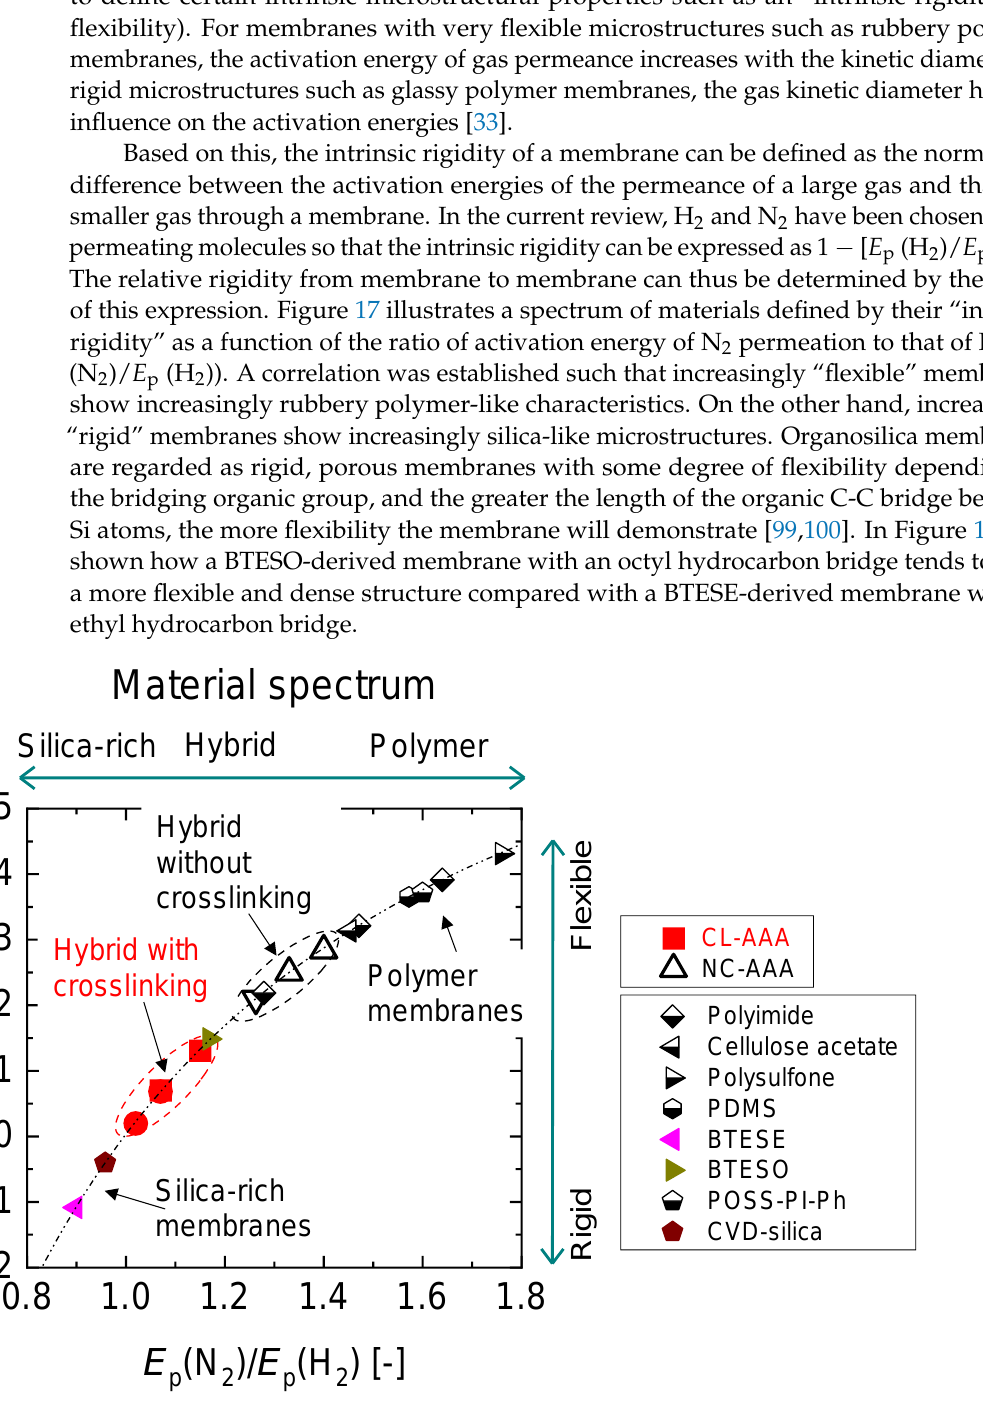
Figure 17. The correlation between “intrinsic rigidity” of 1 − [ E p (H 2 )/ E p (N 2 )] and material class calculated based on E p (N 2 )/ E p (H 2 ) values for different membranes. Adapted from [93]. The NC-AAA membranes show a trend closer to polymer membranes, confirming the theory of flexible non-crosslinked moieties. The CL-AAA membranes, on the other hand, tend to have more “rigid” structures. Therefore, inorganic–organic hybrid materials display different microstructural characteristics depending on the crosslinking state